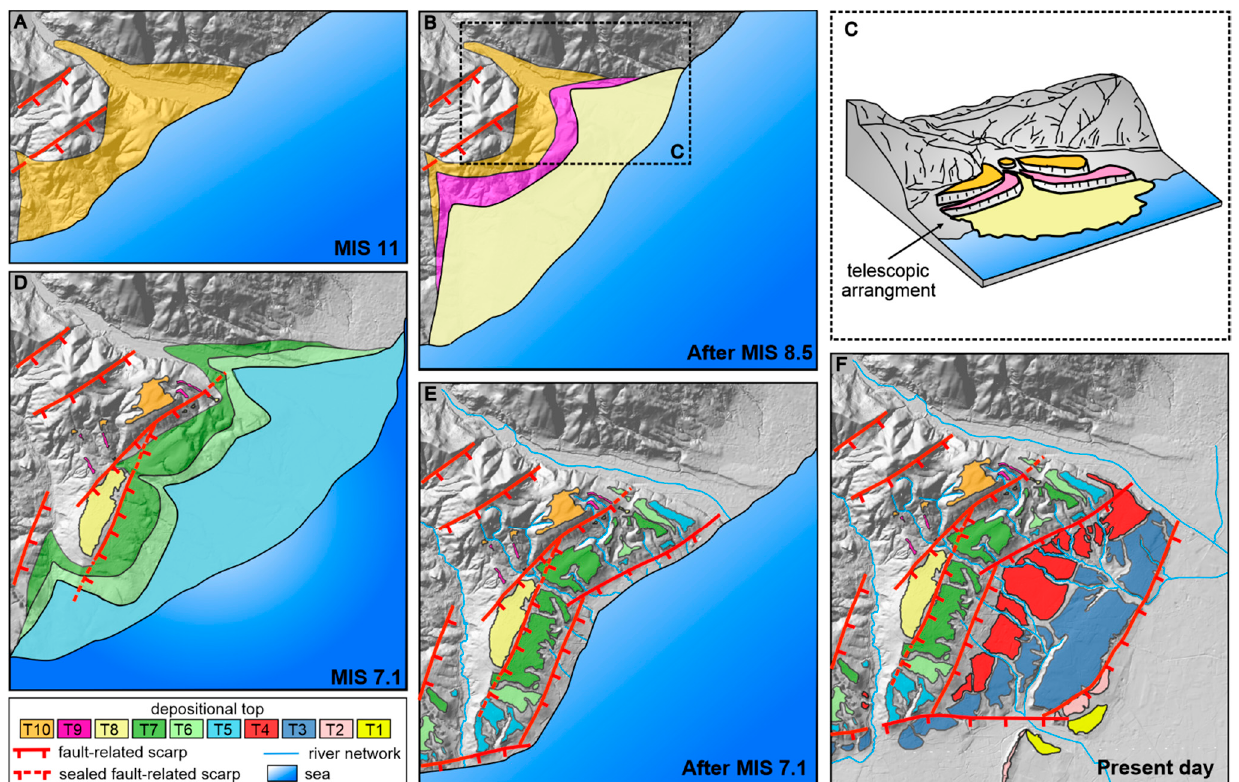
Figure 10. Morphotectonic evolution sketch of the study area. During MIS 11 ( A ), a Gilbert-type delta deposited (T10 terrace). Subsequent relative sea-level changes led to the development of two incised-valley systems ( B ), producing after MIS 8.5 a telescopical arrangement of T10-T8 terraces ( C ). Up to MIS 7.1, a new triplet of depositional bodies formed due to the interplay between uplift and sea-level curve ( D ). A NE-trending fault system hanged the T7-T5 terrace triplet ( E ) and its basinward migration created the accommodation space for the younger depositional wedges which were terraced over time ( F